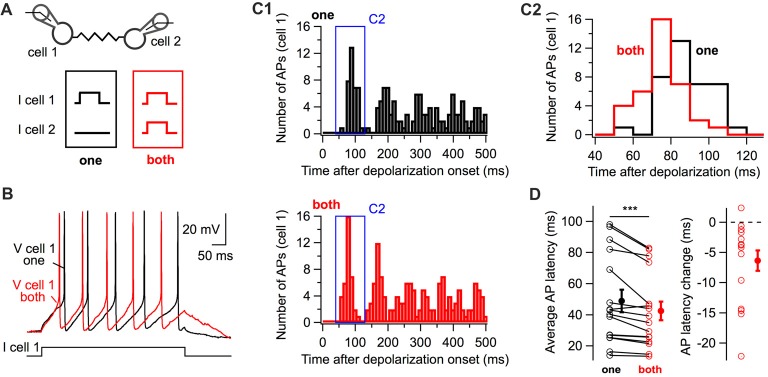
The simultaneous depolarization of a BC regulates the latency of action potential generation in an electrically-coupled BC. (A) Two BCs were recorded in current-clamp mode. Five-hundred millisecond 10 or 20 pA current pulses were injected in one cell (“one” in black) or in both cells (“both” in red) simultaneously. (B) Representative membrane potential traces from cell 1 (“one”, black, “both”, red). (C) Peri-stimulus time histogram (PSTH) computed from all trials for the cell in (B) showing the shortening of action potential latency when both cells are stimulated (C1). The time-window of the PSTH contributed by the first action potential is enlarged in (C2). The distribution of latencies is shifted towards lower values when both cells are simultaneously depolarized. (D) Summary data showing the decrease in the latency of the first action potential triggered by the positive current injection when an electrically-coupled cell is simultaneously depolarized (WSR test, ***P < 0.001). Open symbols represent individual cells and filled symbols average values ± SEM. Left, average AP latencies. Right, change in the latency of the first action potential generated (latency when both cells were depolarized subtracted by the latency when cells were individually depolarized).